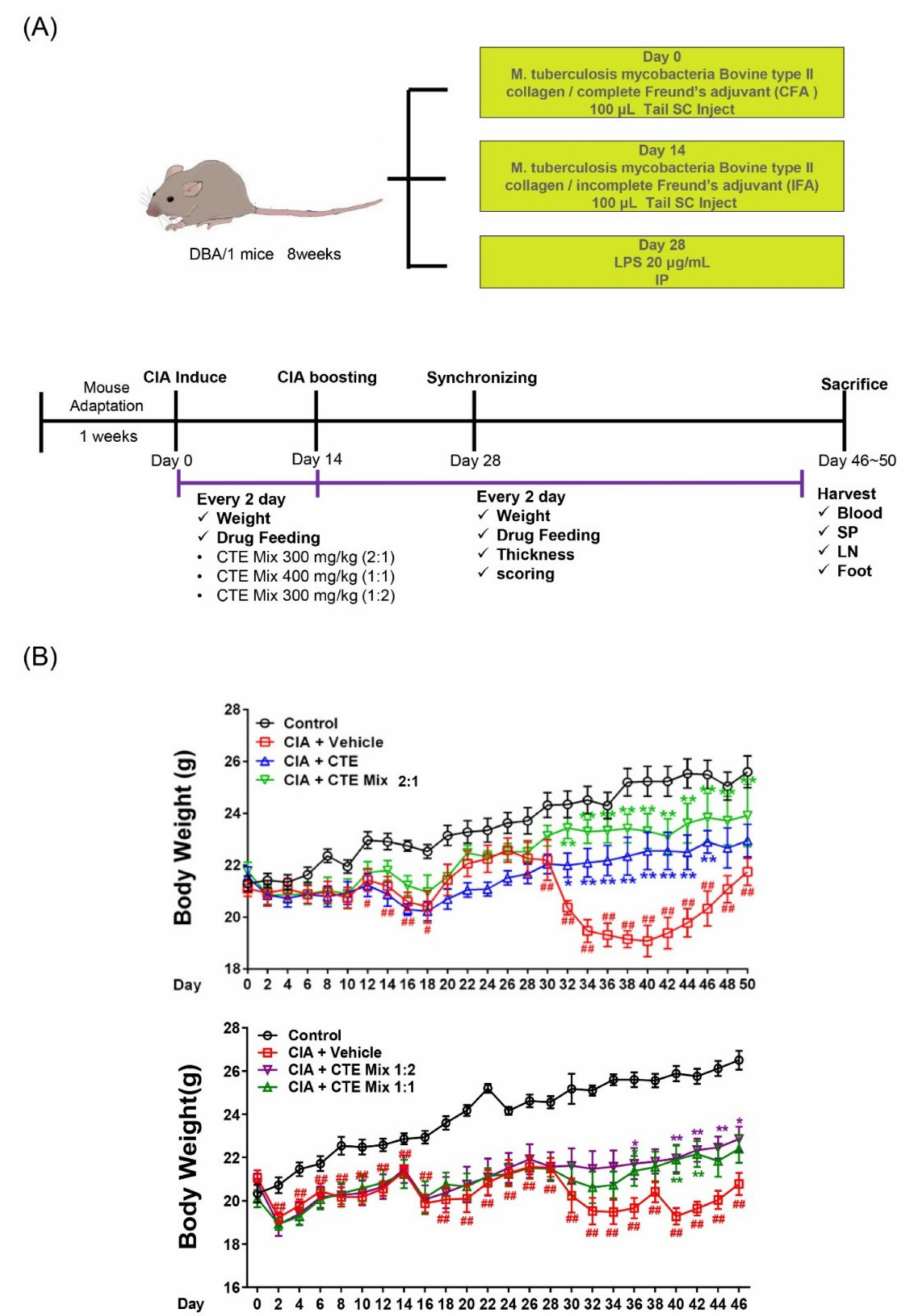
Figure 3. Cytotoxic effect of CTE and CTE mix in CIA-induced animal model. ( A ) In vivo research scheme. ( B ) The control group and vehicle group were administered orally physiological saline. In the CTE group, only CTE was administered orally, while in the CTE/SKE combination groups, these extracts were mixed at the respective concentrations of 2:1, 1:2, and 1:1 and administered orally. The weight change due to the progression of arthritis was then confirmed (control vs. ## p < 0.01, vehicle vs. * p < 0.05, ** p < 0.01; n =